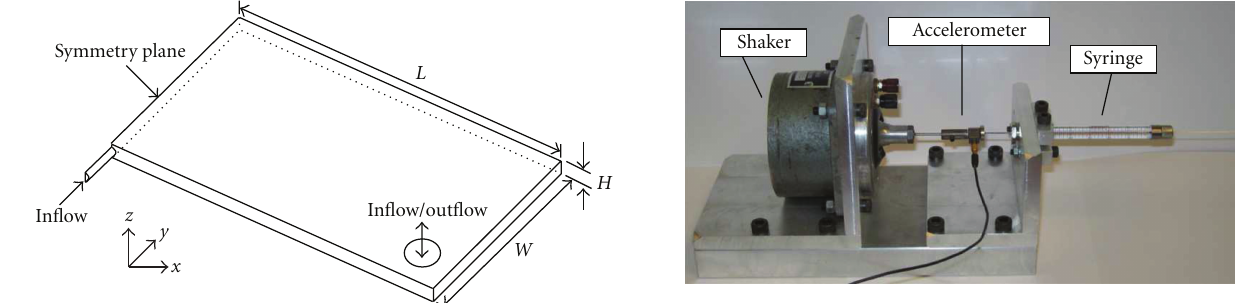
Figure 3: Experimental